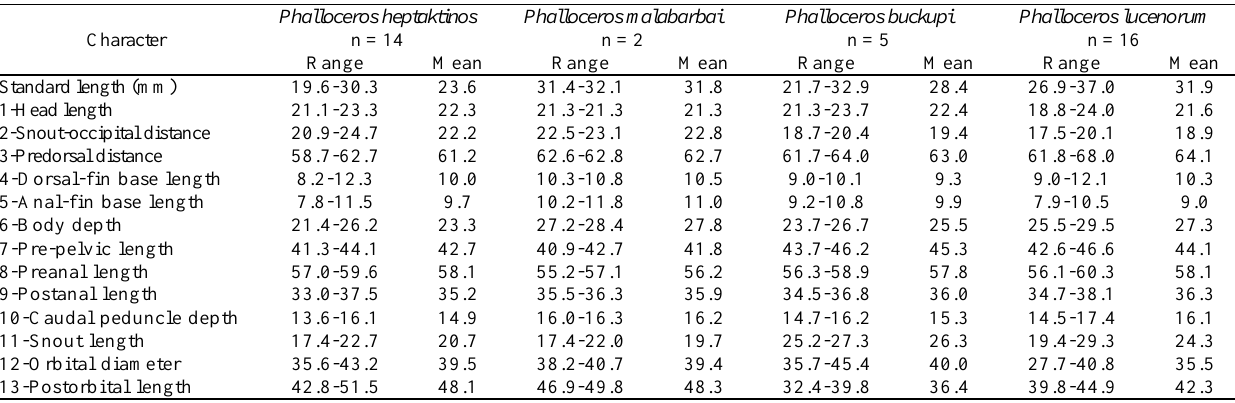
Figs. 8, 9 Phalloceros sp. n. A Lucinda & Reis, 2005. Horto Florestal Mariana (RIOCELL), approx. 30 o 21’S 51 o 36’W, Table 3. Descriptive morphometrics of female specimens of Phalloceros heptaktinos , P . malabarbai , P. buckupi , and P . lucenorum . Measurements 1-10 are percents of standard length and measurements 11-13 are percents of head length.